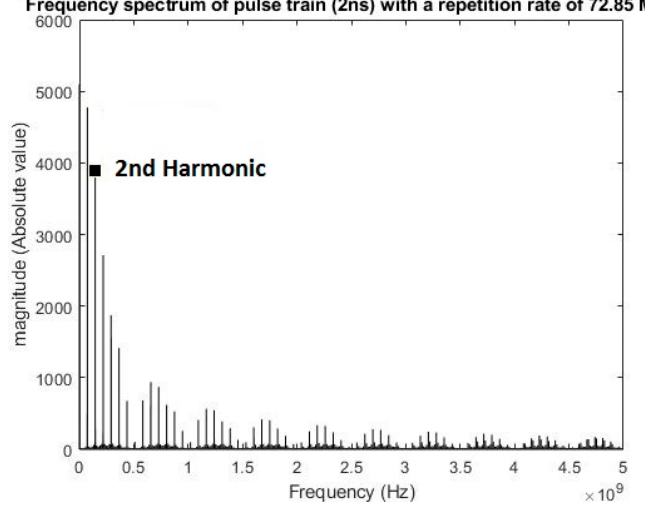
Figure 4. Frequency spectrum of a 2ns pulse train with a repetition rate of 72.85 MHz.